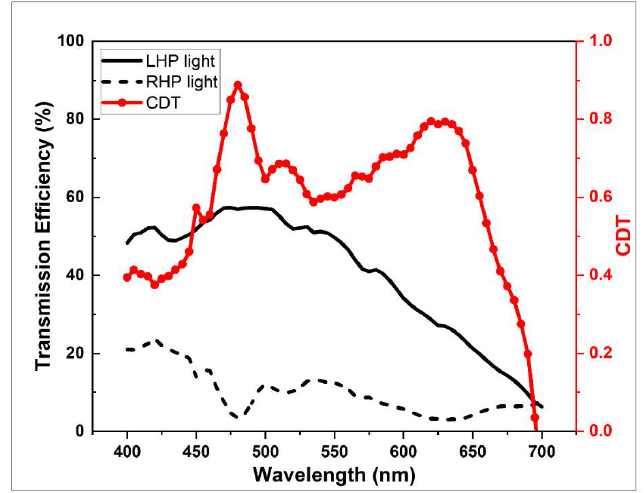
Figure 9. Simulation results of smaller LHDCP in a single-pixel size of 2.4 × 2.4 µ m 2 : Black lines are the transmission spectra of our LHDCP under LHP and RHP incident light, the red line is the CDT calculated from the above two transmission spectra.